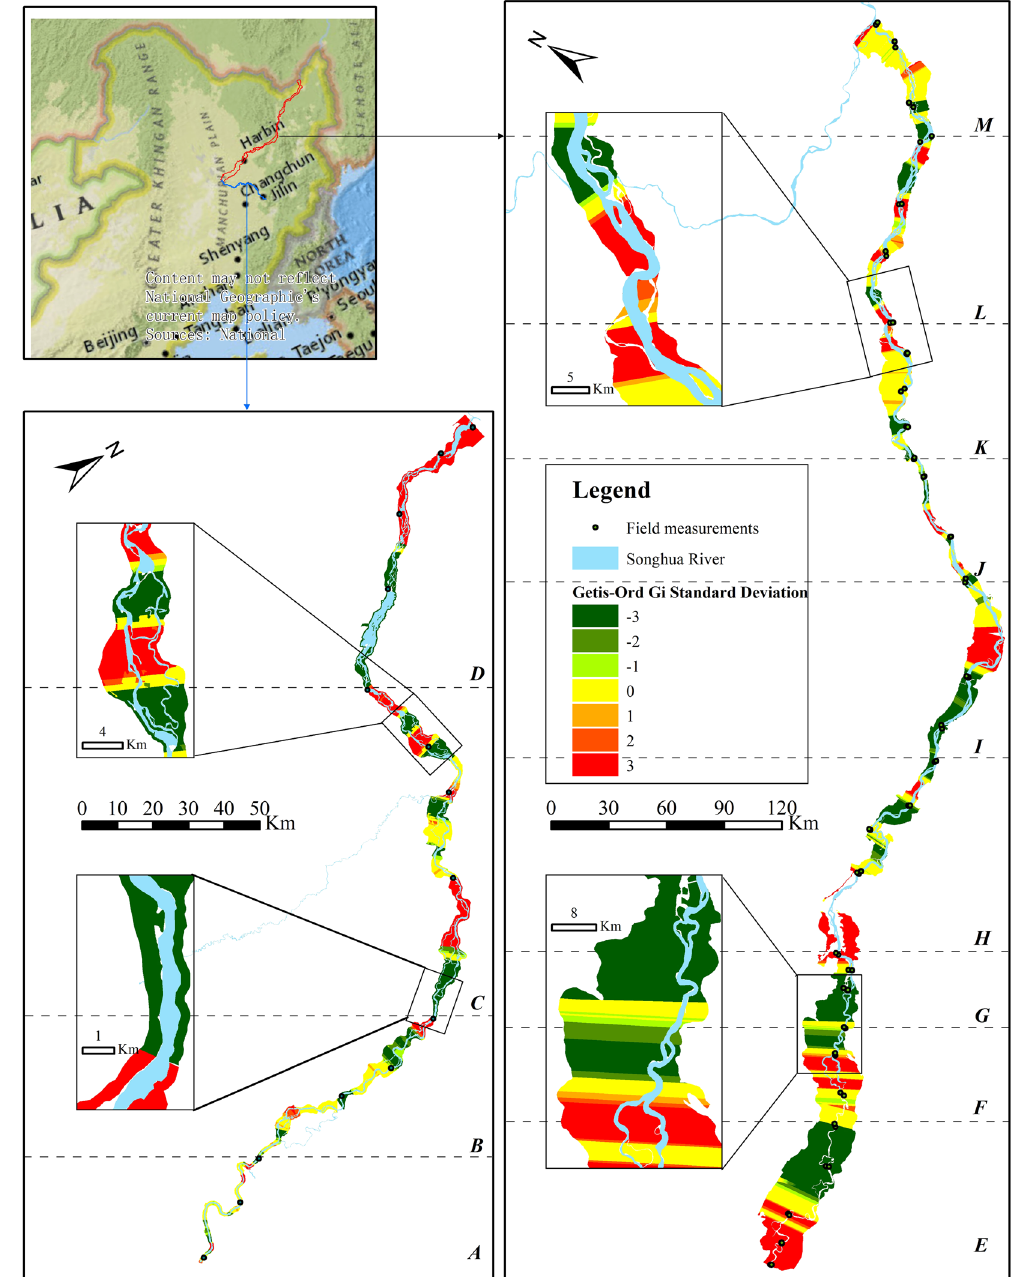
Figure 8. Getis-Ord Gi spatial statistics for the riparian PSI value was calculated and mapped by ArcGIS 10.3 software (http://www.esri.com/software/arcgis). Negative z-scores (z < − 1.65, p < 0.1) represent statistically significant clusters of small PSI values, and become cold spots at the 90–95% confidence interval. Positive z-scores (z > 1.65, p < 0.1) indicates statistically significant clusters of high PSI values, and become hot spots at the 90–95% confidence interval. Clusters were non-significant ( − 1.65 < z < 1.65) in neighborhoods with a wide variation in PSI values, indicating those riparian conditions were randomly distributed. A-M were the thirteen measurement sections. The locus map is the World Topographic Map basemap within ArcGIS 10.3 software. The map is credited to: Esri, HERE, DeLorme, Intermap, increment P Corp., GEBCO, USGS, FAO, NPS, NRCAN, GeoBase, IGN, Kadaster NL, Ordnance Survey, Esri Japan, METI, Esri China (Hong Kong), swisstopo, MapmyIndia, © OpenStreetMap contributors, and the GIS User Community.